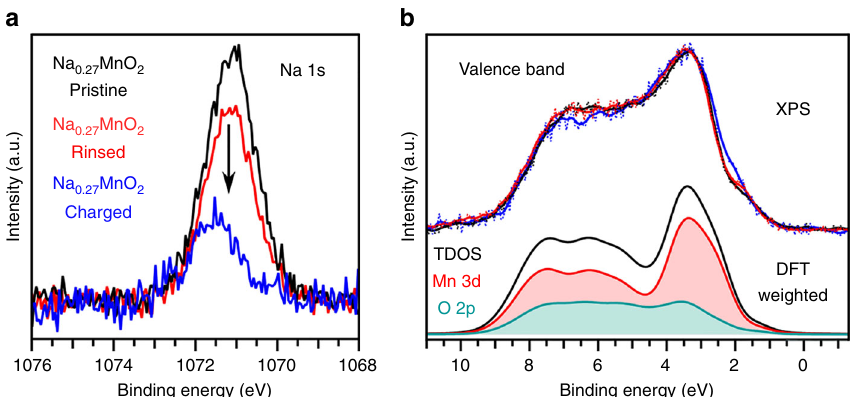
Fig. 7 XPS and DTF analysis of Na 0.27 MnO 2 .XPS measurements. a Na 1 s region for pristine Na 0.27 MnO 2 powder, Na 0.27 MnO 2 powder rinsed in the Na 2 SO 4 electrolyte, and b valence band of Na 0.27 MnO 2 electrode charged to 1.25 V (vs Ag/AgCl). The valence band XPS spectra are compared with DFT calculations of the TDOS and the Mn 3d and O 2p PDOS for the Na 0.27 MnO